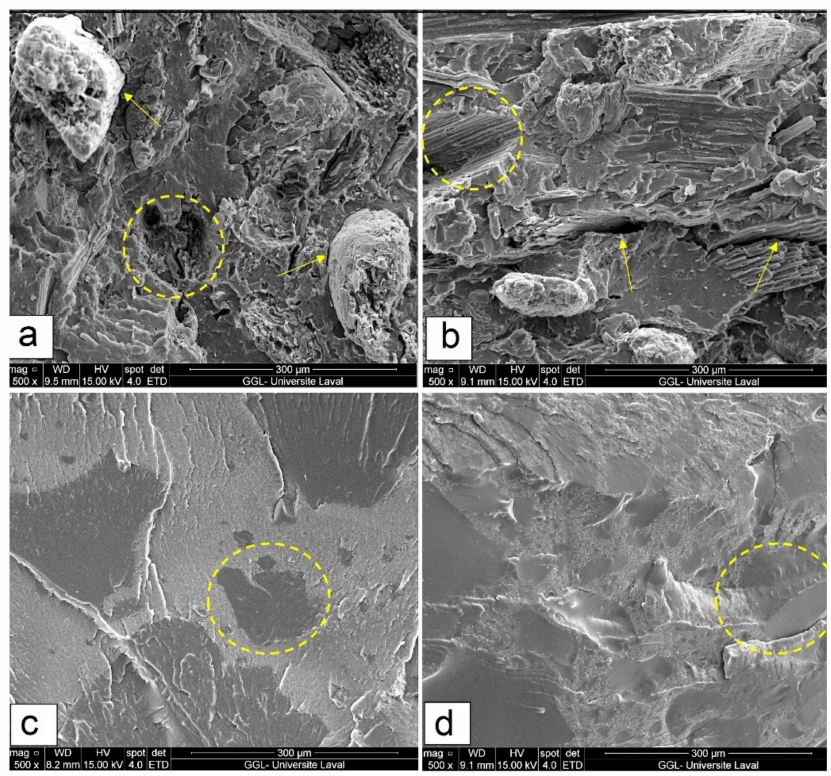
Figure 2. SEM micrographs of ( a ) F20, ( b ) F40, ( c ) R20 and ( d ) R40 composites (IM) (see Table 1 for